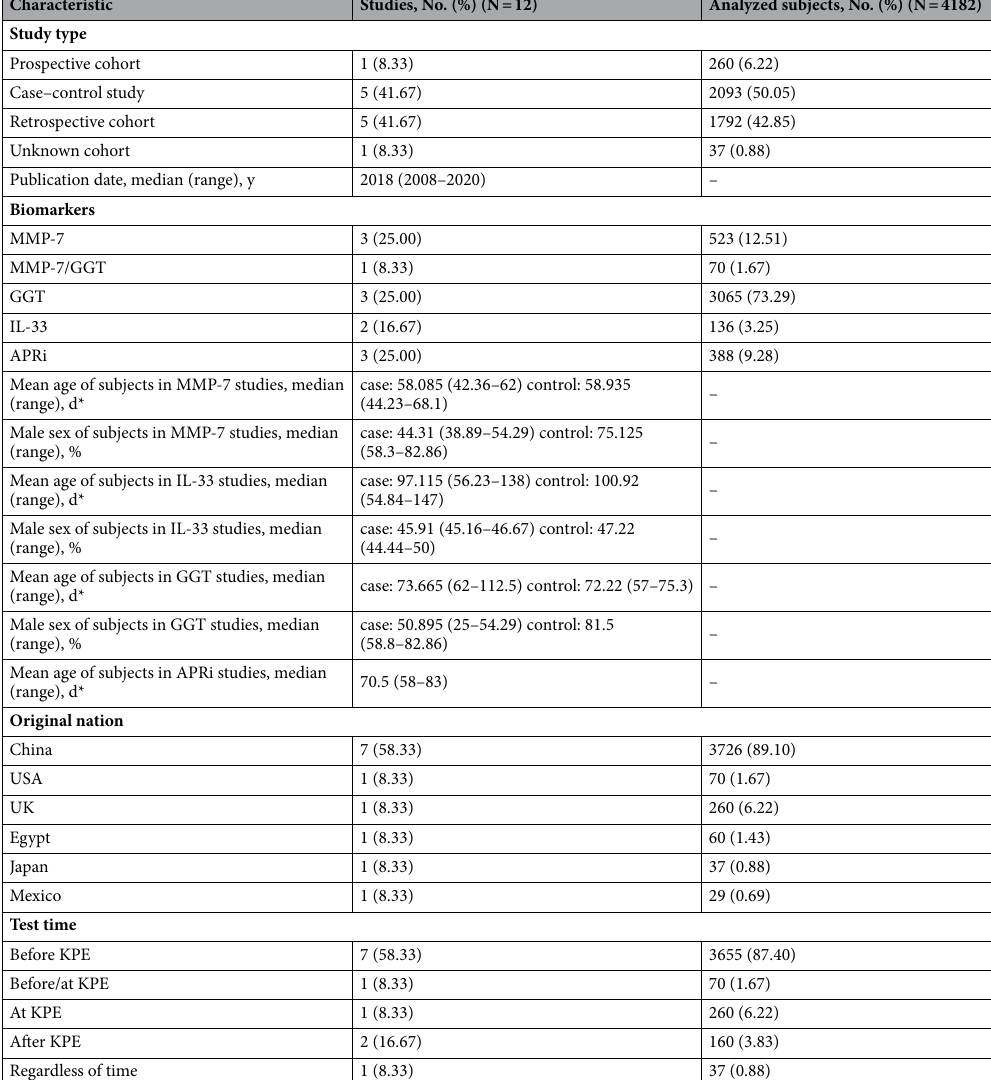
Table 2. Characteristics of the included studies in the “patient-level” analysis. Abbreviations: MMP-7, matrix metallopeptidase-7; IL-33, interleukin 33; GGT, γ-glutamyl transferase; APRi, aspartate aminotransferase to platelet ratio index; M2BPGi, Mac-2-binding protein glycosylation isomer; KPE, Kasai portoenterostomy. *Age of subjects is calculated from the day of birth to the day of sample